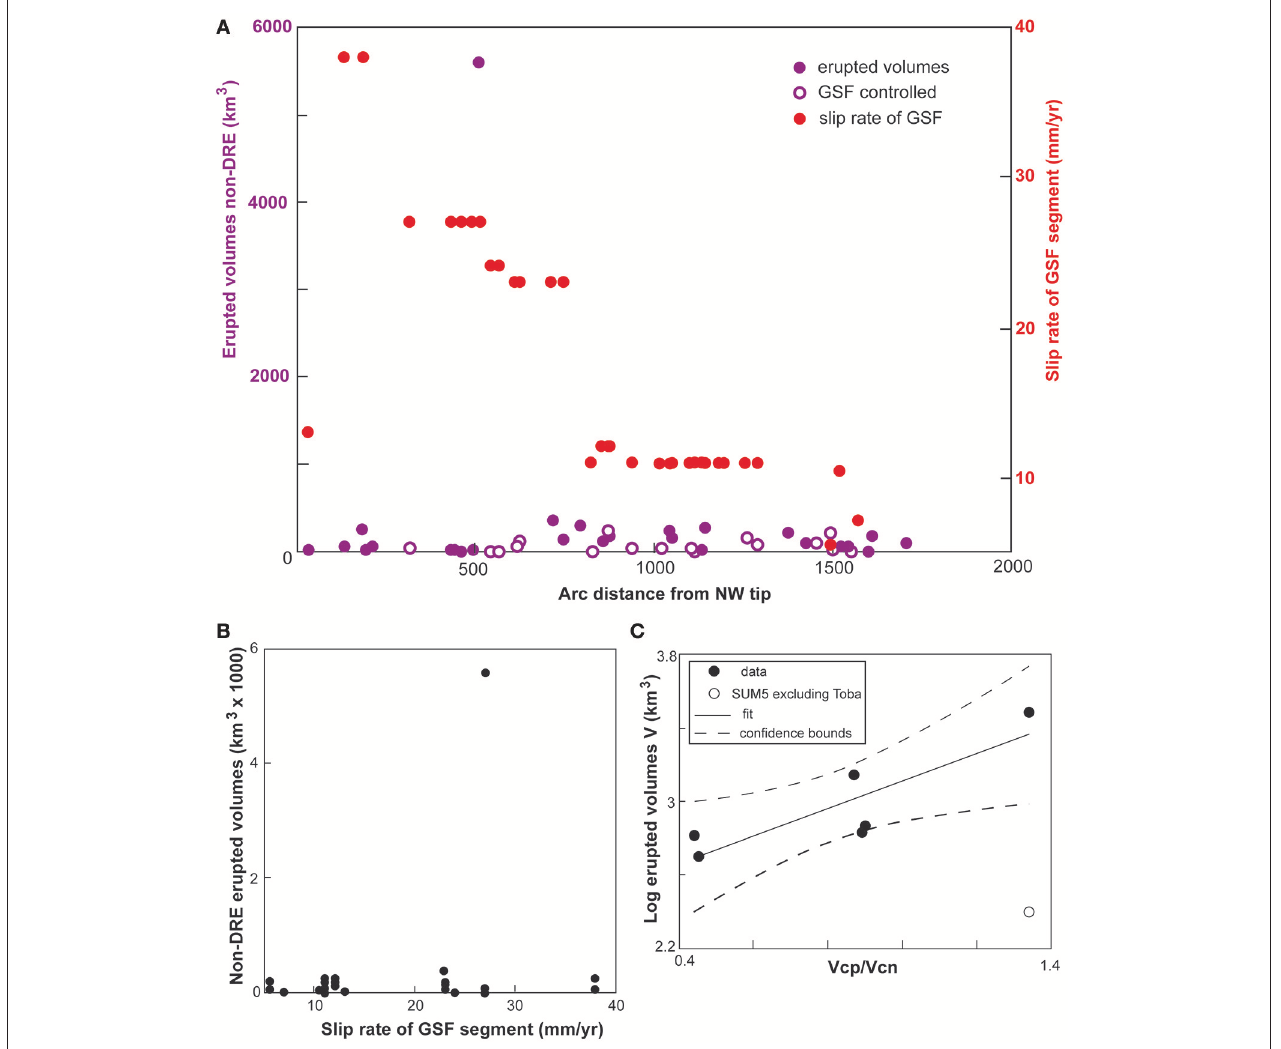
FIGURE 6 | (A) Non-DRE (except for Toba) erupted volumes and GSF slip rates along the Sumatra arc; (B) GSF fault slip vs. non-DRE erupted volumes at Sumatra; (C) Log of non-DRE erupted volumes as a function of the obliquity of convergence, expressed as the ratio between the amount of parallel convergence (Vcp) and that of orthogonal convergence (Vcn); see text for